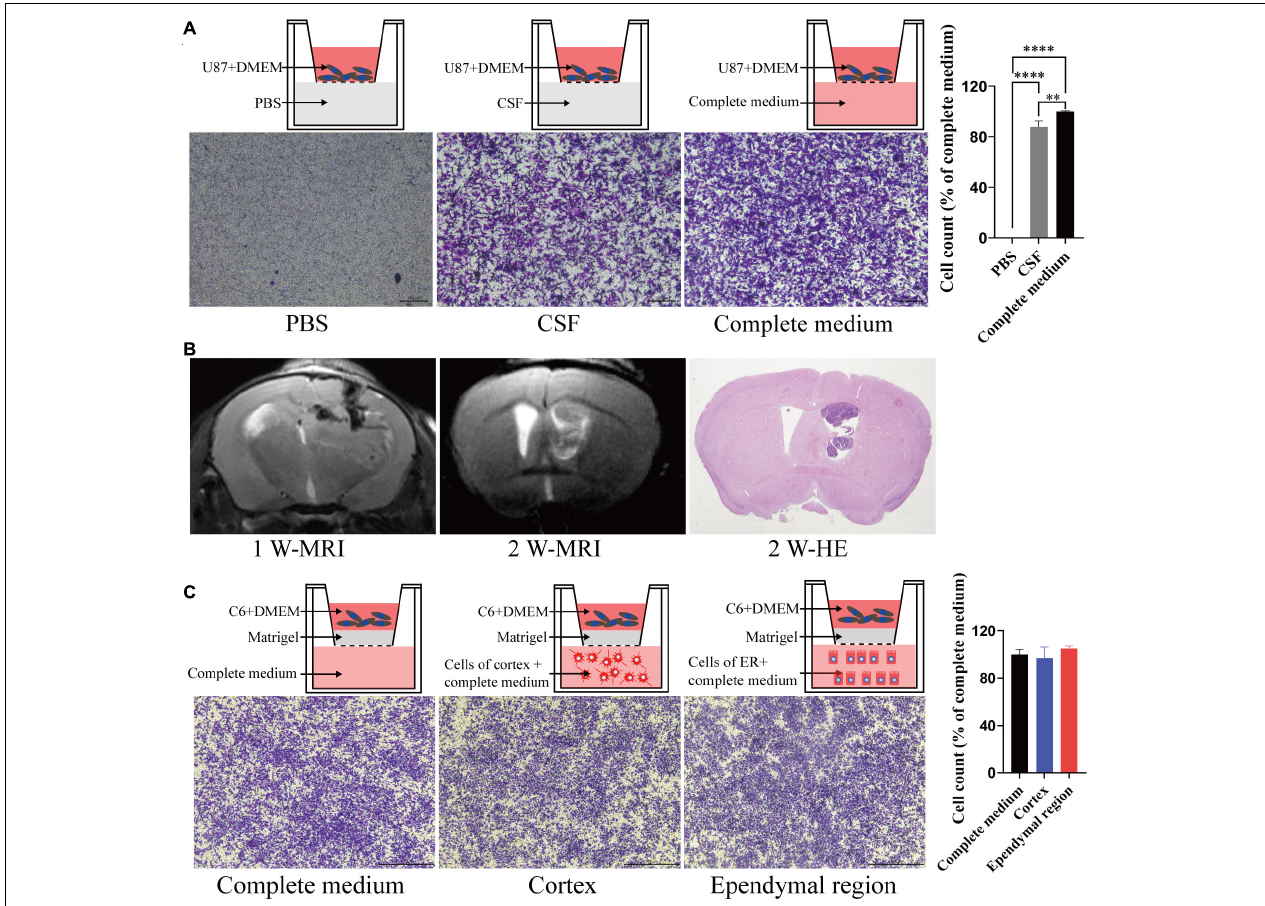
FIGURE 4 | The effects of different components of the cerebral cortex on tumor cell migration and invasion. (A) CSF can induce tumor cell migration. (B) GL261 cells were injected into the lateral ventricle of C57/BL6 mice; MRI was performed in the first week and second week after injection and then upon sacrifice, and the brain tissue was further examined by HE staining. (C) There was no significant difference in the induction of tumor cell invasion between the ependymal region group, cortex group and complete medium group. Migration and invasion were allowed to proceed for 4 h. ∗∗ p < 0.01, ∗∗∗∗ p < 0.0001; ER, ependymal